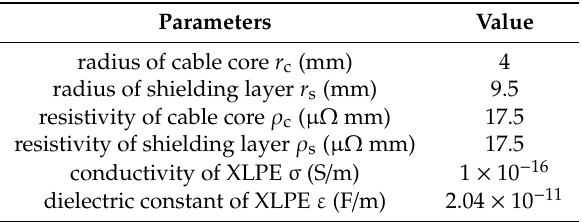
Table 1. The parameters of the simulated cable model